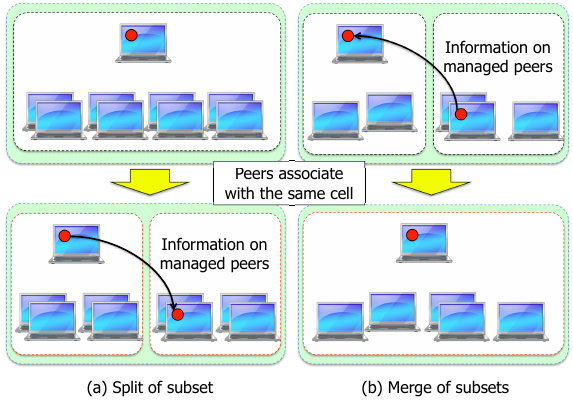
Fig. 5. Split and merge